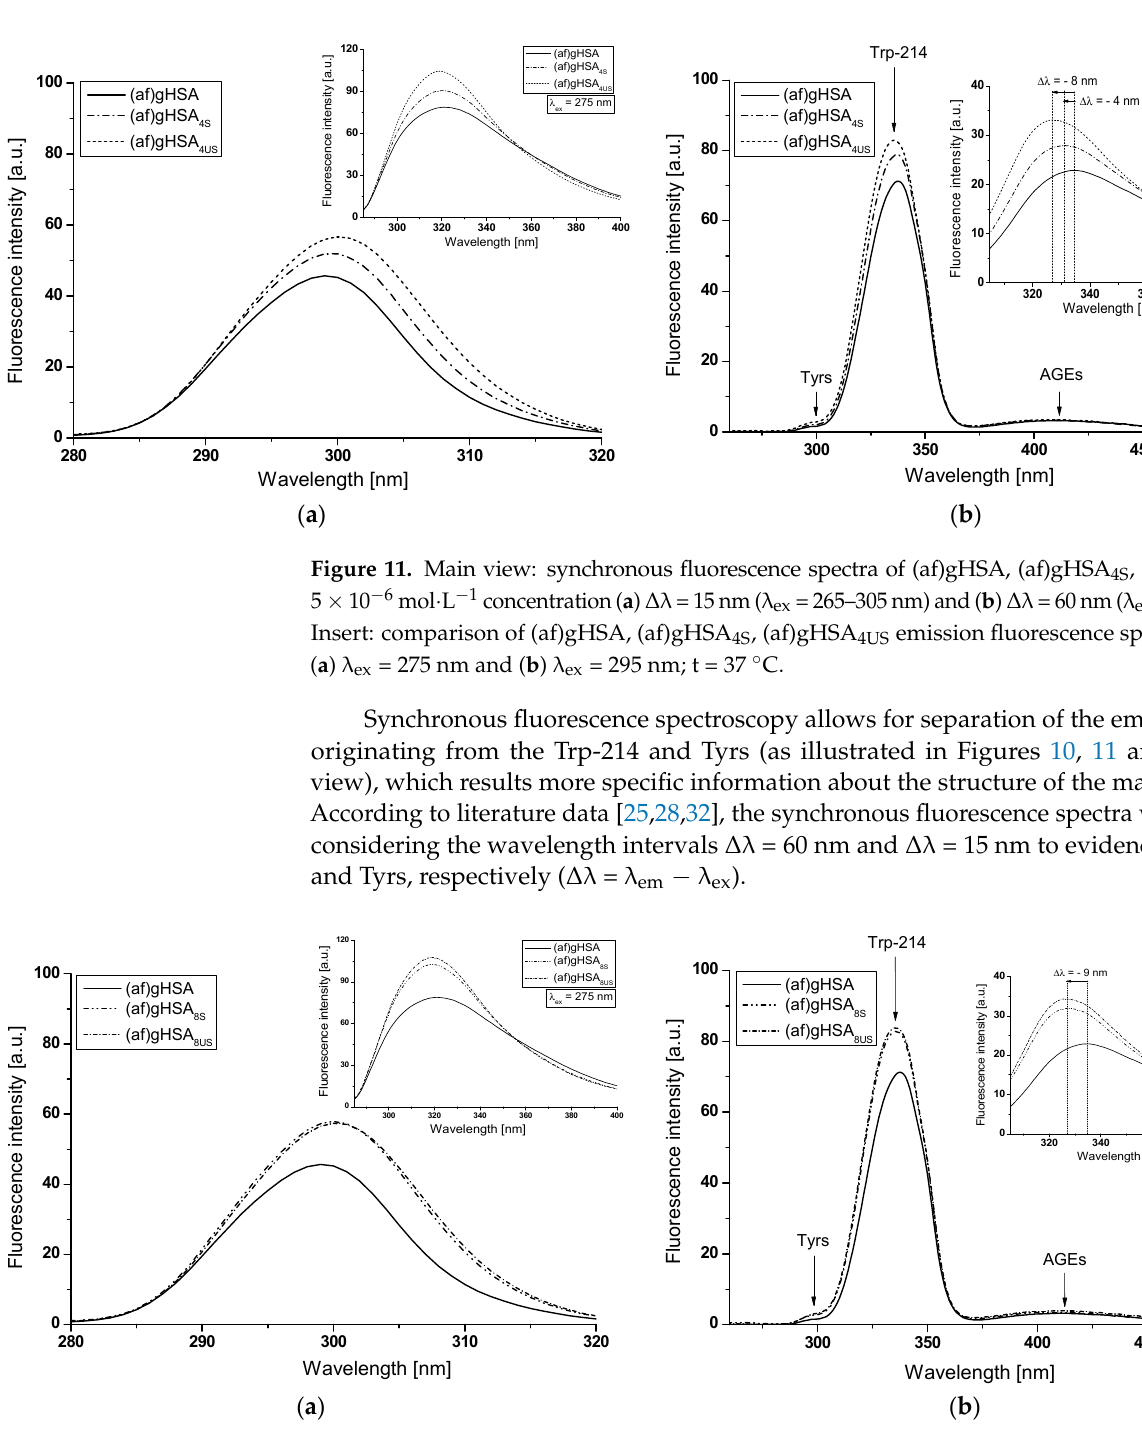
Figure 12. Main view: synchronous fluorescence spectra of (af)gHSA, (af)gHSA 8S , (af)gHSA 8US at 5 × 10 − 6 mol ∙ L − 1 concentration ( a ) Δλ = 15 nm ( λ ex = 265–305 nm) and ( b ) Δλ = 60 nm ( λ ex = 220–440 nm). Insert: comparison of (af)gHSA, (af)gHSA 8S , (af)gHSA 8US emission fluorescence spectra excited at ( a ) λ ex = 275 nm and ( b ) λ ex = 295 nm; t = 37 °C.